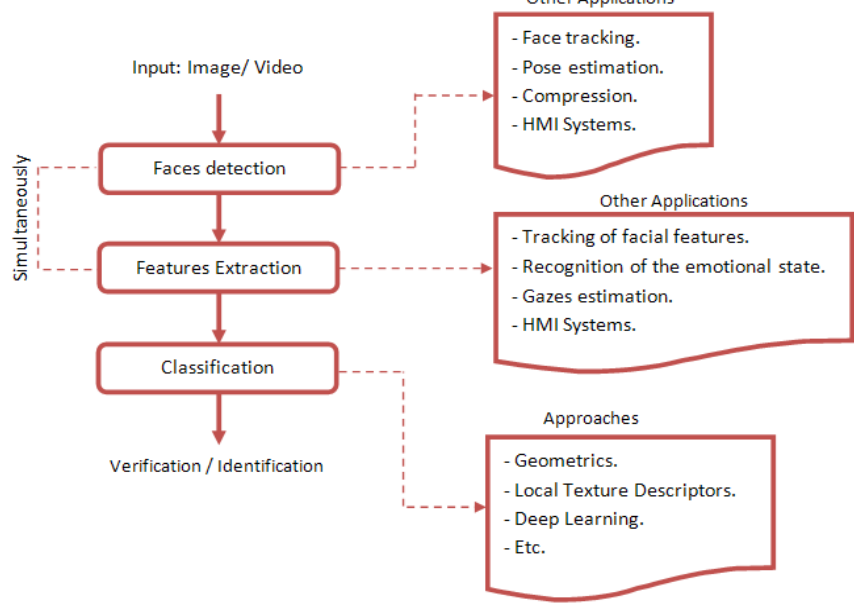
Figure 2. The standard design of an automated face-recognition system.